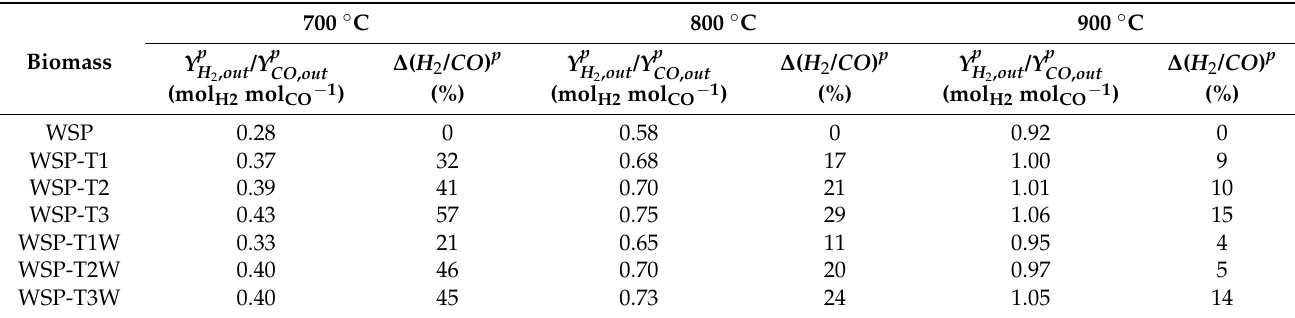
Table 6. Peak analyses at 700, 800, and 900 ◦ C: H 2 /CO molar ratio related to peaks, obtained as the ratio between regression lines of Y p and Y p (Equation (7), m and q from Tables 3 and 4) for each biomass; relative percentage variation of H 2 , out CO , out H2/CO ratio related to peaks, referred to WSP values ∆ ( H 2 / CO ) p